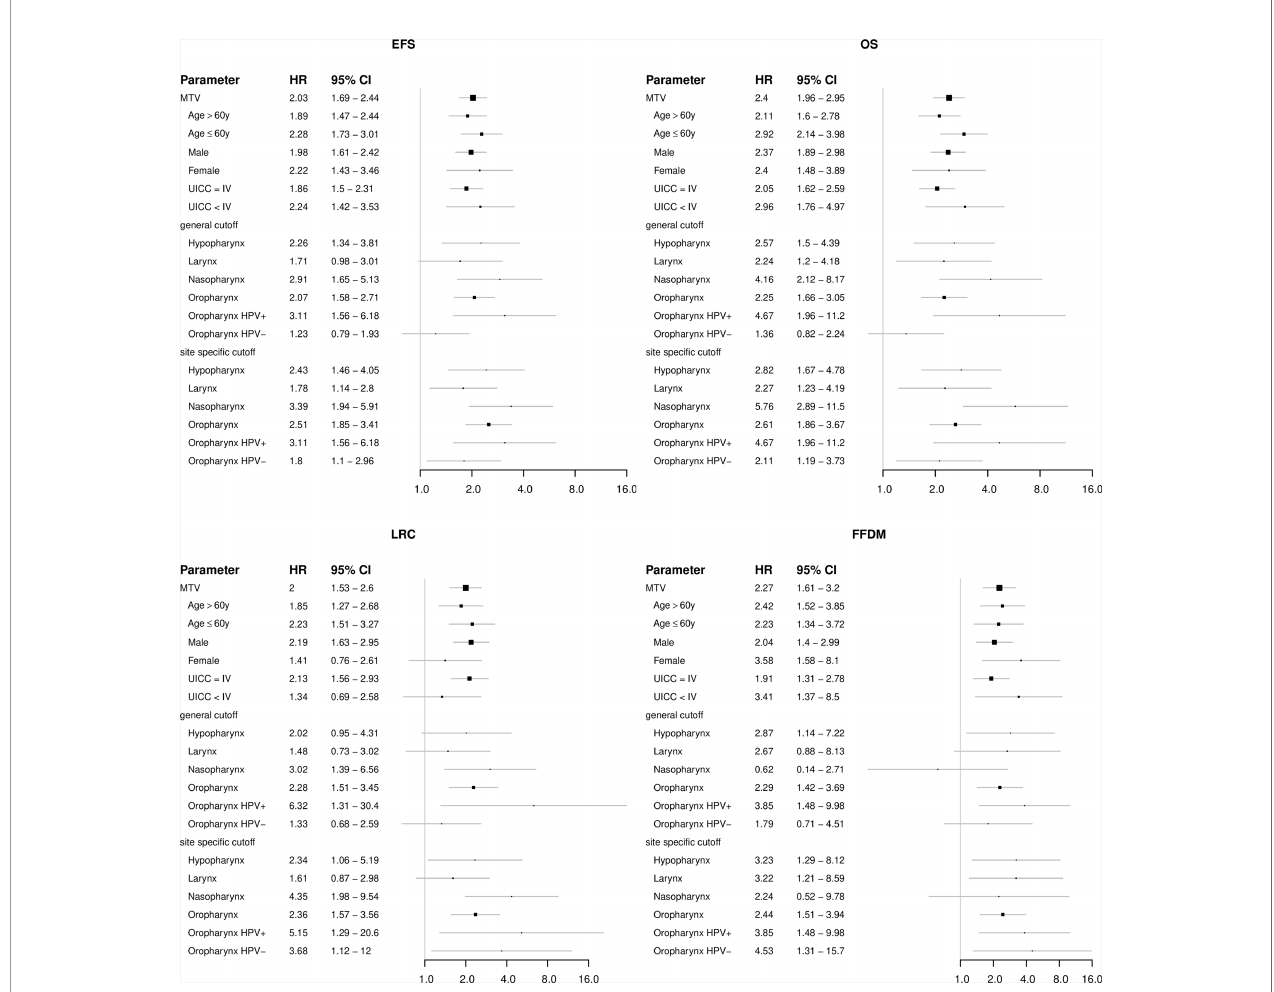
FIGURE 3 | Forest plots showing the prognostic value of the FDG-PET parameter metabolic tumor volume (MTV) in subgroups of patients regarding the clinical endpoints EFS, OS, LRC and